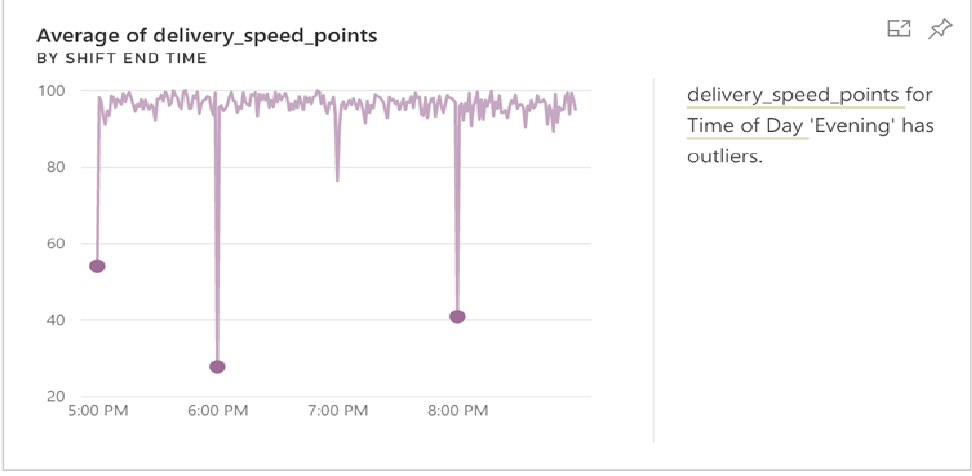
Figure 7. Outlier detection using quick insights.